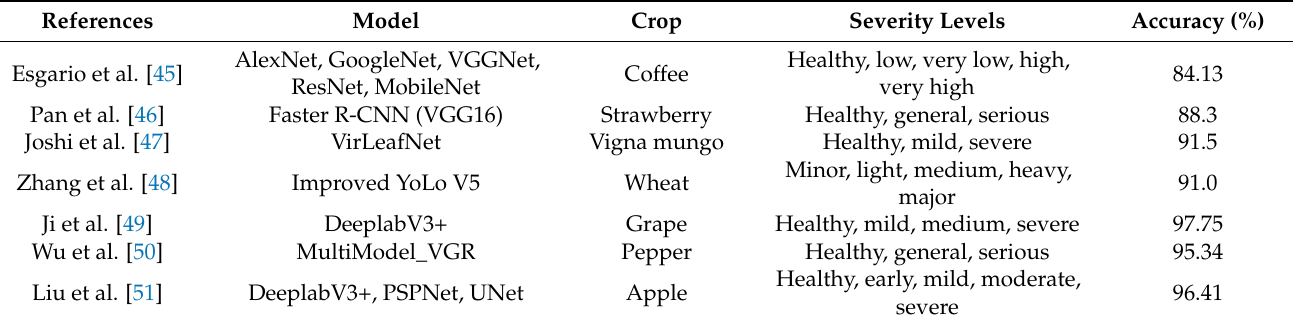
Table 1. Summary of the studies on the evaluation crop disease severities based on deep learning methods.